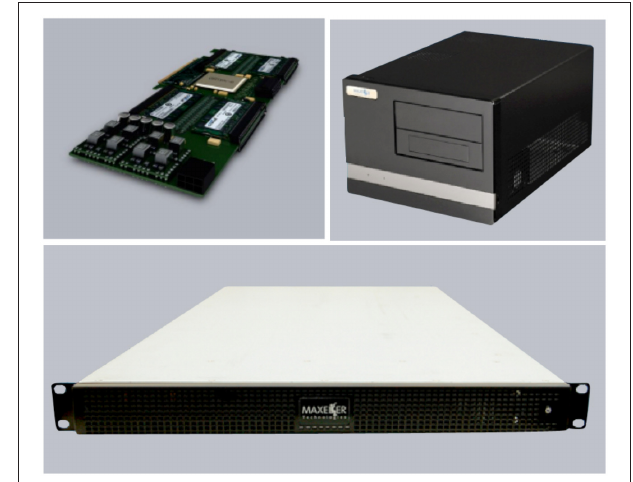
FIGURE 2 | Sample Maxeler systems the NeuroFlow neural simulator run on. Upper left : A single system board containing one FPGA; upper right : workstation with a single FPGA card; bottom: a 1U server